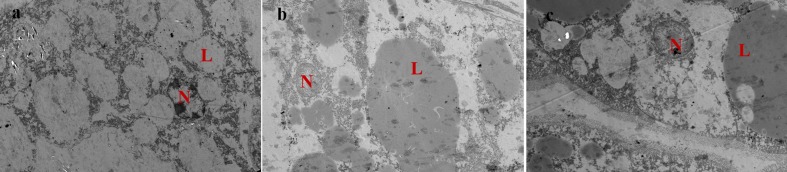
Transmission electron microscope images of Macrobrachium rosenbergii hepatocyte ultrastructure (1200 ×). (a) Prawns fed diet including 6% fish oil (DFO); (b) Prawns fed diet including 6% soybean oil (DSO); (c): Prawns fed diet including 6% rapeseed oil (DRO). N: nucleus; L: lipid droplet.